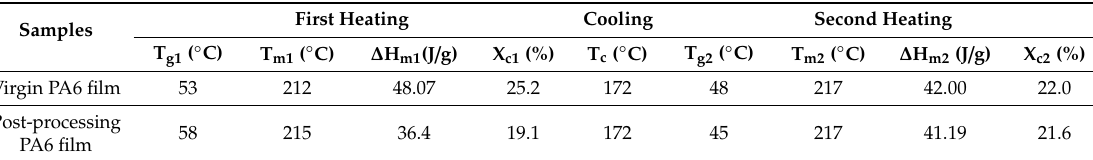
Figure 2. Differential scanning calorimetry (DSC) thermograms of the virgin and post-processing PA6 films. ( a ) First heating, ( b ) cooling, and ( c ) second heating. Table 2. Values of T g , T m , Δ H m, and X c obtained during first and second heating scans and T c obtained during the cooling scan for the virgin and post-processing PA6 films.